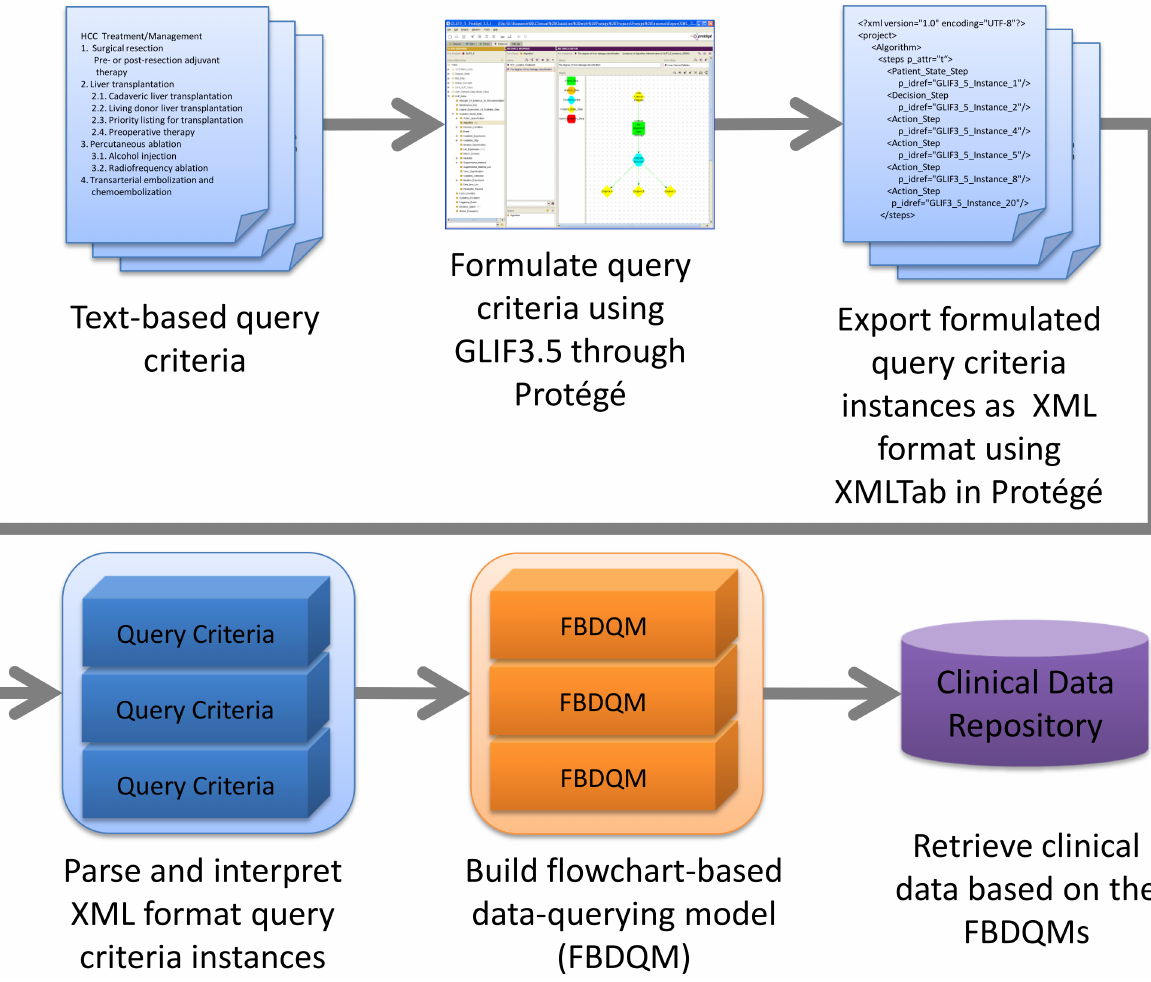
Clinical Practice Guideline Representation